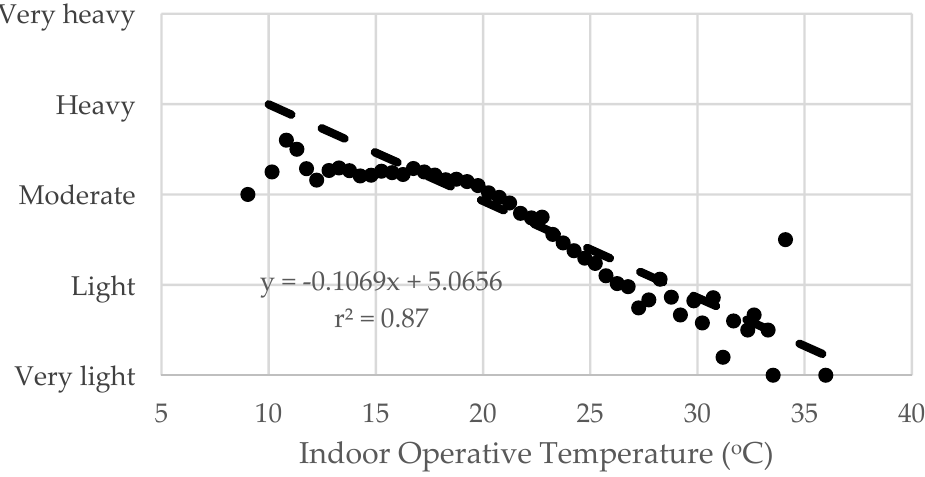
Figure 7. Clothing level, as reported by the participants, vs. indoor operative temperature.